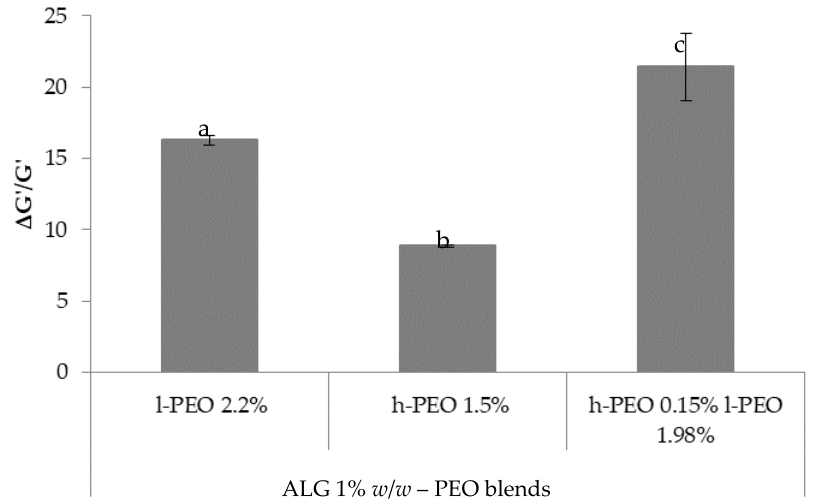
Figure 12. ΔG′/G′ values calculated for blends containing ALG 1% w/w with l-PEO 2.2%, h-PEO 1.5% and l-PEO 1.98%/h-PEO 0.15% (mean values ± SD; n = 3). One-way ANOVA, Multiple Range Test ( p < 0.05); a vs. b, c; b vs. c.